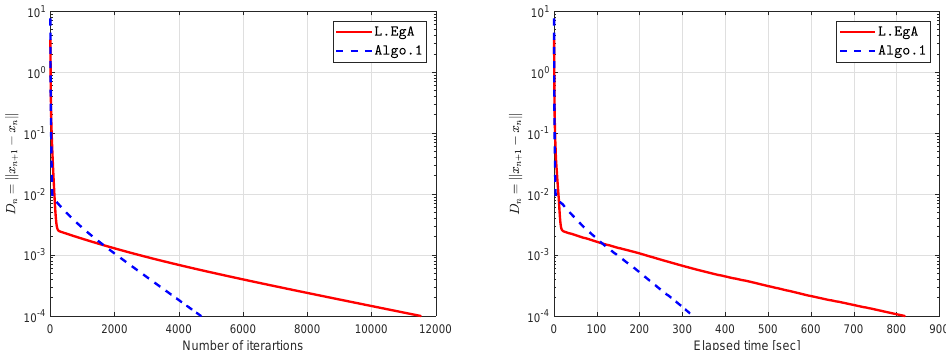
Figure 3. Example 1 while tolerance is 0.0001.